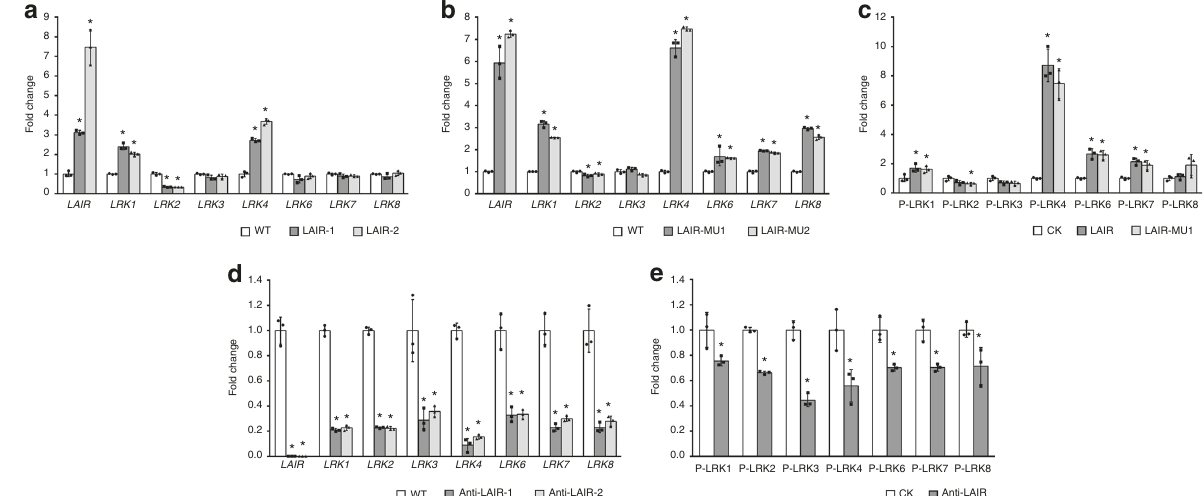
Fig. 3 Differential regulation of LRK gene expression by LAIR . a , b , d qRT-PCR analysis of LRK expression in transgenic rice lines. LAIR -overexpressing ( a , LAIR-1 and LAIR-2), LAIR -mutant ( b , LAIR-MU1 and LAIR-MU2), and antisense RNAi- LAIR vectors ( d , Anti-LAIR-1 and Anti-LAIR-2). WT: wild-type rice. OsActin was used as a reference control, and gene expression levels in WT lines were used for data normalization. c , e Regulation of the LRK gene promoter by sense or antisense LAIR . Relative LUC activity from the transient expression of the LRK promoter-driven luciferase reporter gene co-in fi ltrated with sense- LAIR ( c , LAIR), LAIR -mutant ( c , LAIR-MU1), or antisense LAIR ( e , Anti-LAIR) vectors. CK: empty vector control. The CK LUC/REN signal ratios were used for data normalization. All data are presented as the mean ± standard deviation ( n = 3). Student ’ s t -test: * P <